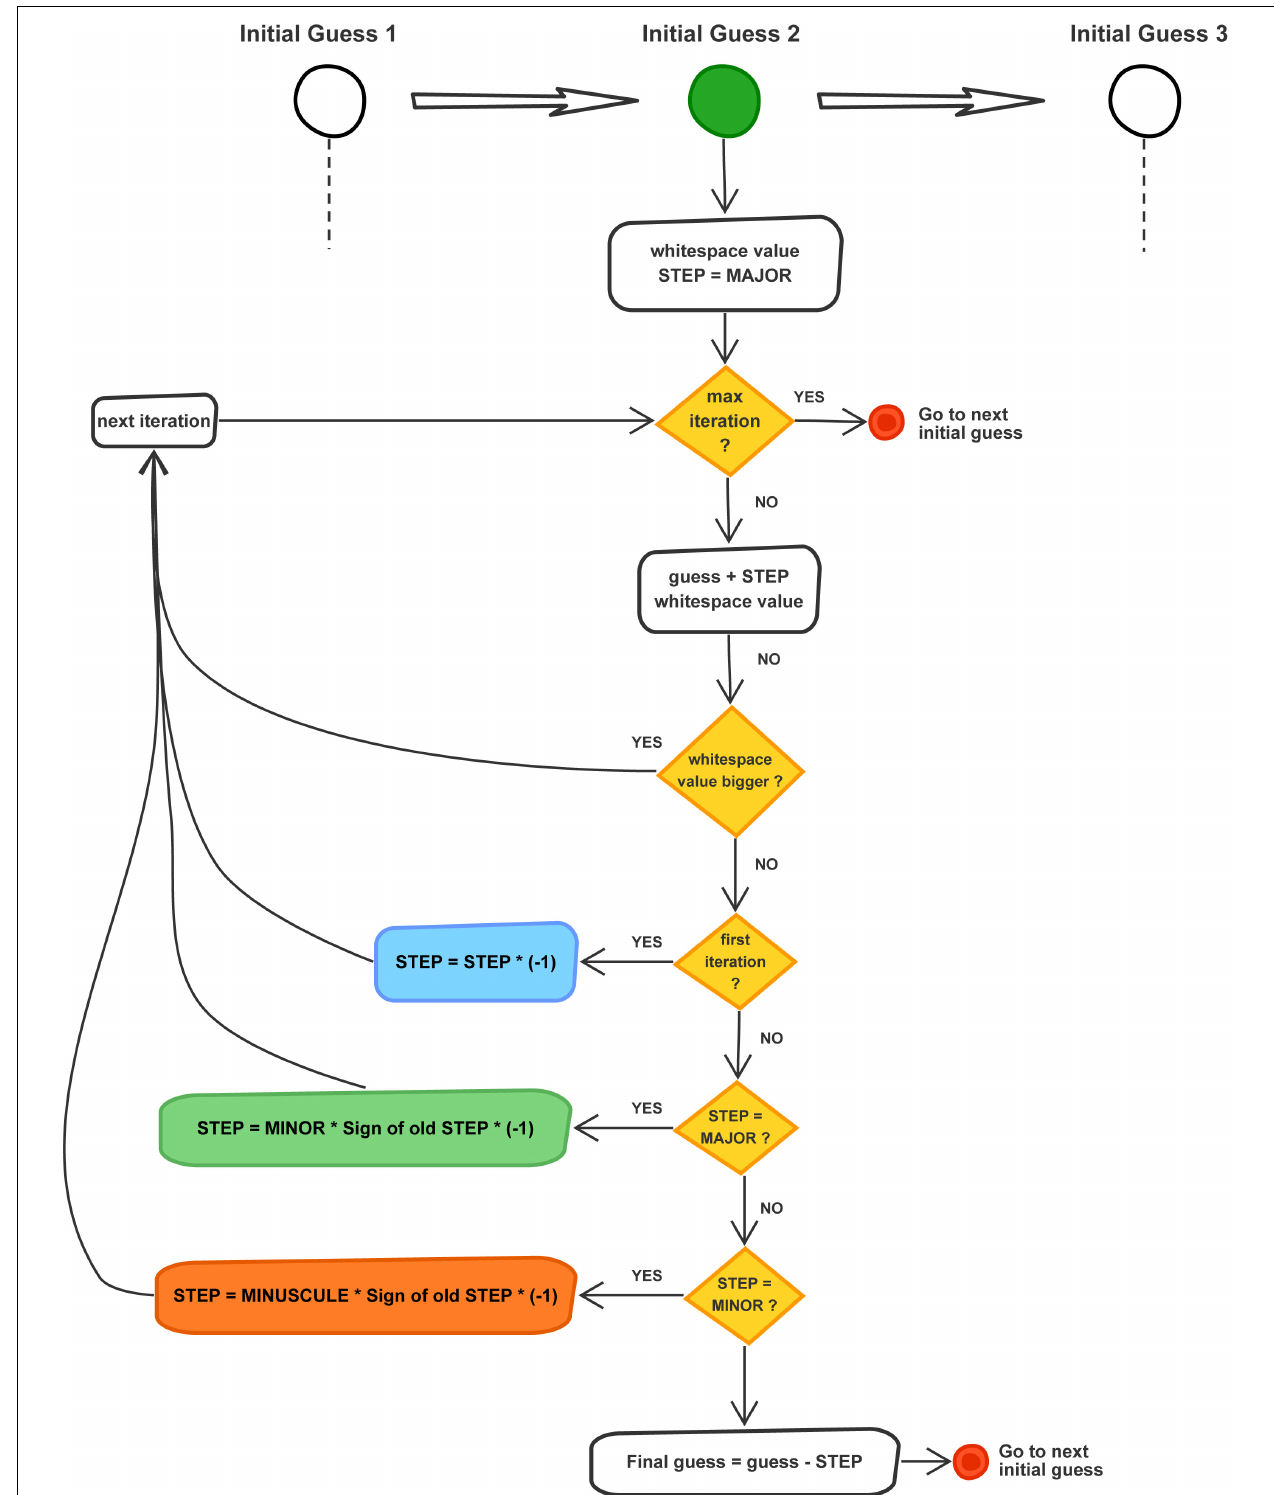
FIGURE 7 | Flow diagram for the whitespace maximization component of the SOCIB glider salinity DM scientific correction toolbox. For the sake of brevity, only the second initial guess procedure is shown as all initial guess procedures are the same.